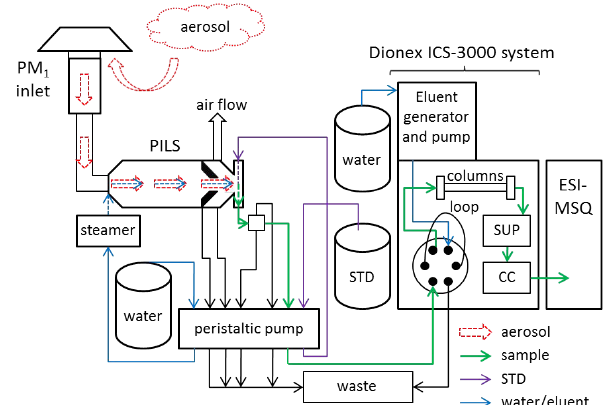
Fig. 1. Schematic representation of the sampling line and the online coupled PILS–HPAEC–MS apparatus. Arrows represent the flow of the aerosol sample and the liquids within the system. STD = standard solution containing internal standard and standard addition of levoglucosan; SUP = suppressor; CC = conductivity cell; ESI- MSQ = quadrupole mass spectrometer with electrospray ionization. The figure is not to